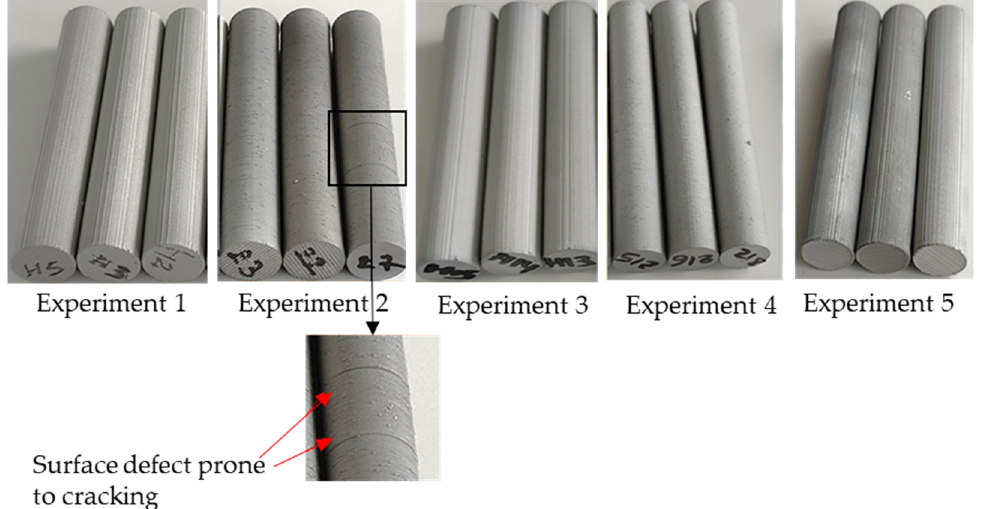
Figure 6. The macroscopic aspects of obtained cylindrical parts from experiments 1–5 and details of surface defect from experiment 2.